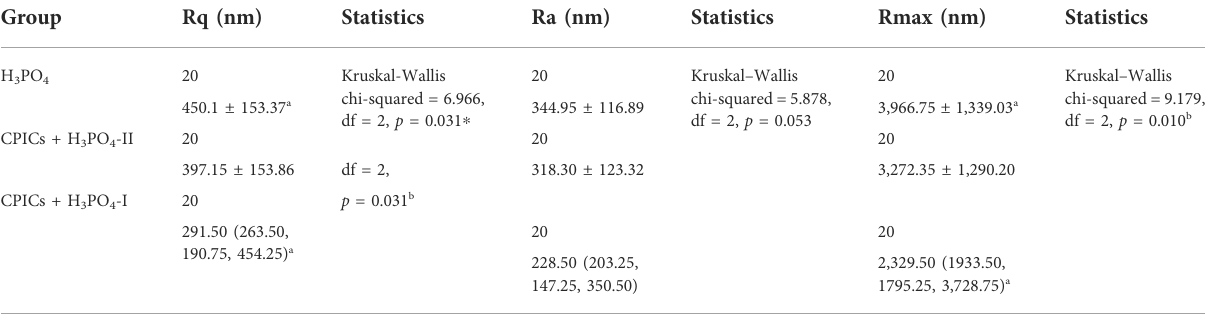
TABLE 5 Roughness values for the acid-etched